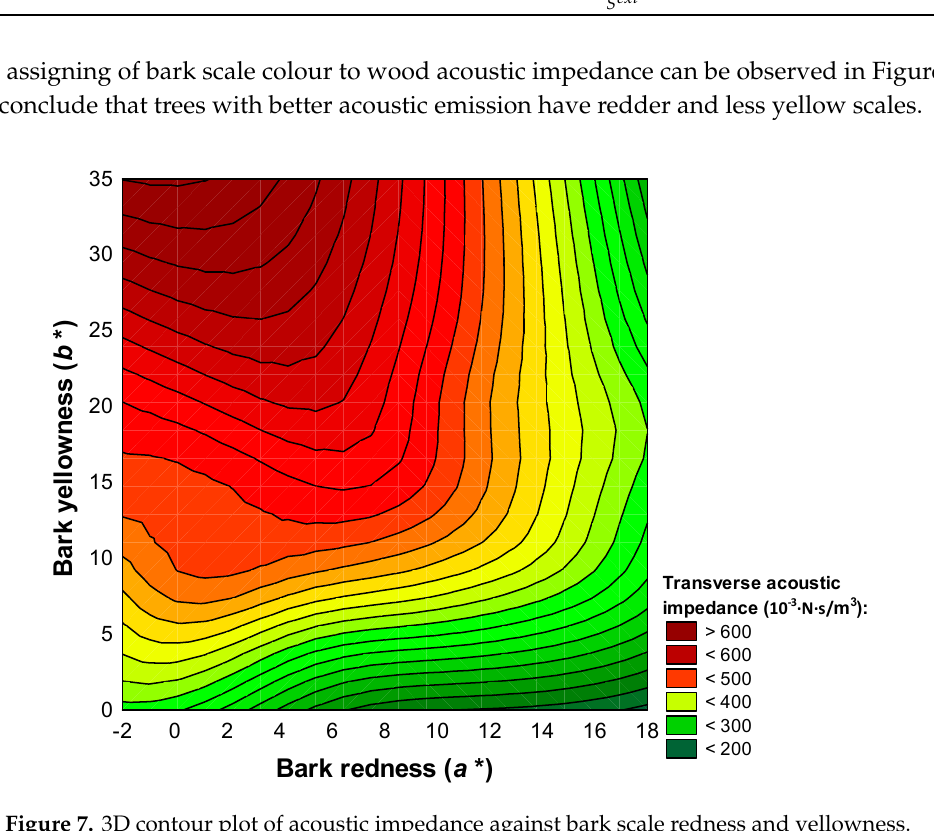
Figure 6. 3D contour plot of acoustic impedance against bark scale redness and yellowness. Figure 7. 3D contour plot of acoustic impedance against bark scale redness and